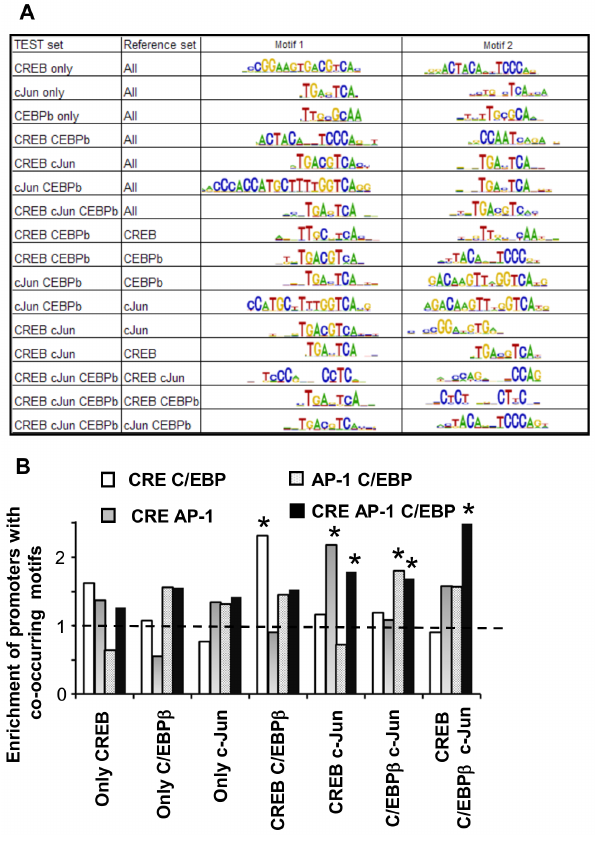
Figure 6. Combinations of consensus motifs and composite motifs are enriched in the groups of promoters bound by different combinations of transcription factors. A. Top DNA motifs mostly enriched in test sets v.s. background sets of promoters in the 2 500 bp…0 bp relative to the transcription start site. Motifs are sorted by enrichment and statistical confidence level using CisFinder. For CREB, c-Jun C/EBP b set cJun and C/EBP b bound promoters were used as a background. B. Enrichment of promoters containing only two or three transcription factors consensus binding motifs in groups of promoters bound by different combination of transcription factors in undifferentiated keratinocytes. Consensus motifs for CREB (CRE) - TGACGTCA, C/EBP b - (C/EBP) TTGCGCAA and for c-Jun (AP-1) TGA(C/ G)TCA. Note that promoters containing combination of motifs are overrepresented in the groups of promoters bound by corresponding transcription factor. * - numbers are different from expected (p , 0.05).